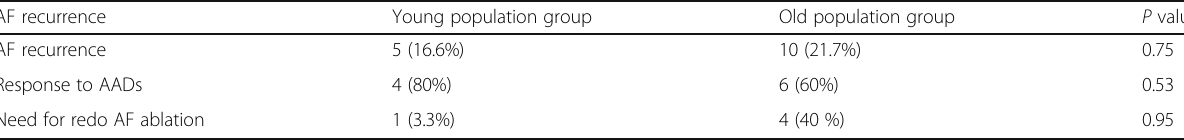
AF atrial fibrillation, AADs antiarrhythmic